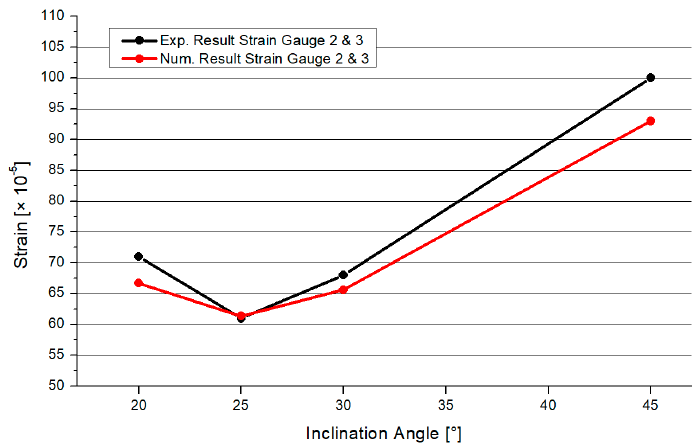
Figure 2. Validation Experimental–Numerical results [27].